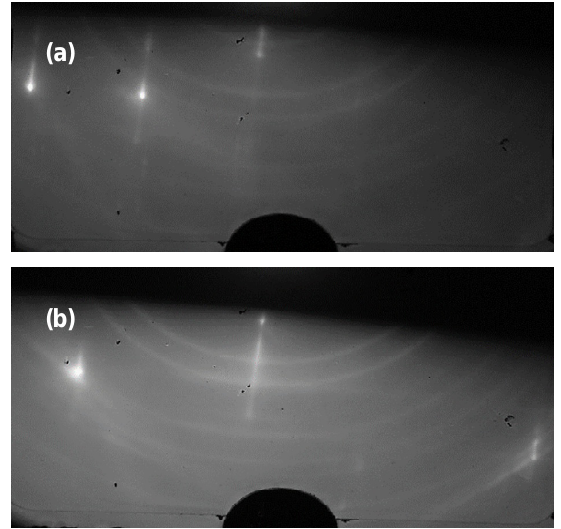
Fig. 8. RHEED patterns of the SiC layer, grown on Si(111)/c-plane Al O (Fab-2-C-plane sapphire), pro- 2 3 jected onto the axis [110] (a) and projected onto the axis [112] (b).